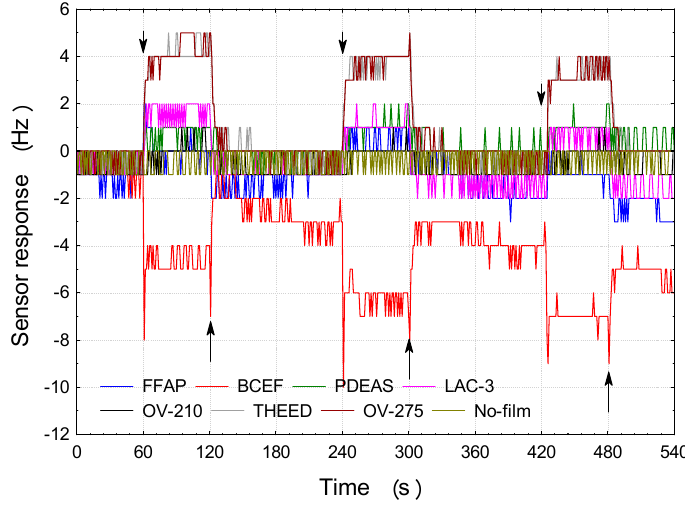
Figure 2. Transient responses of 7 QCM sensors to benzaldehyde at 250 ppb and 0% RH.